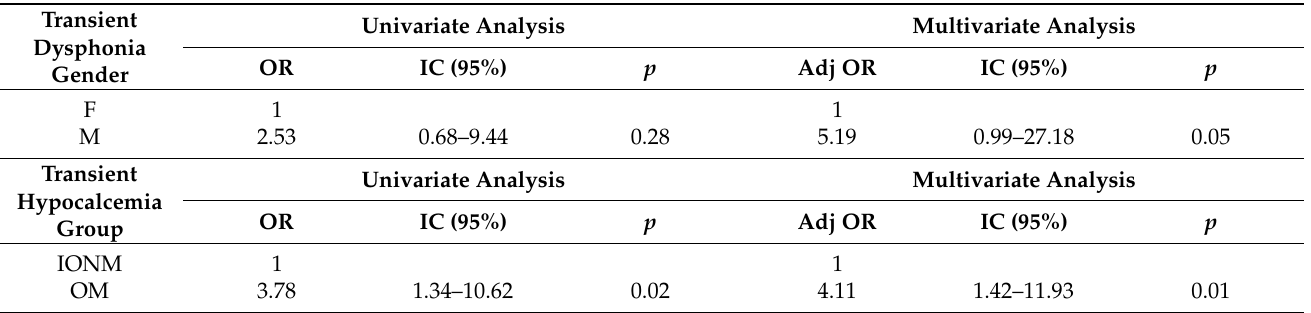
Table 2. Results of logistic backward analysis for transient dysphonia and transient